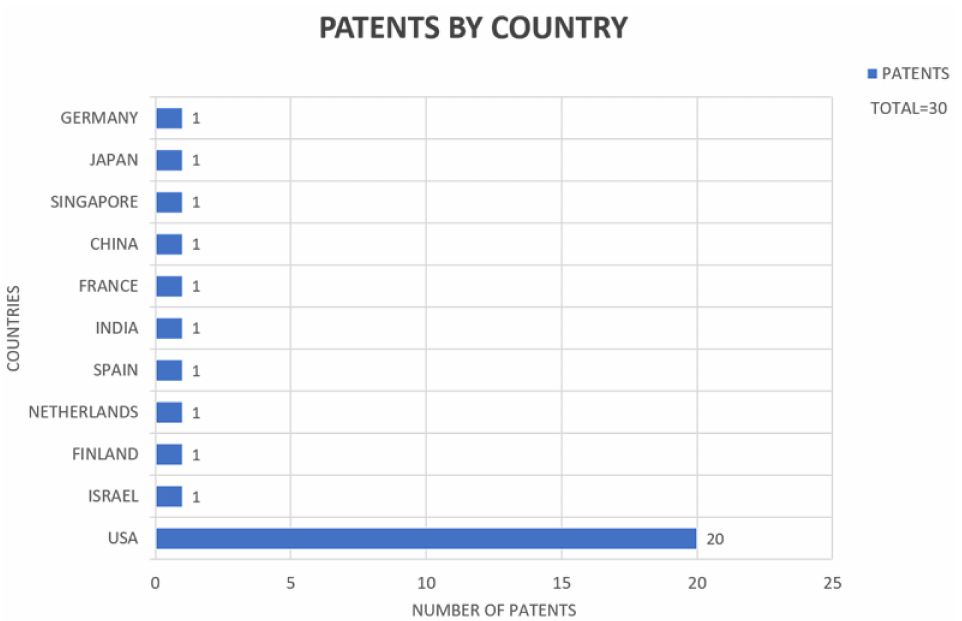
Figure 3. Number of patents per